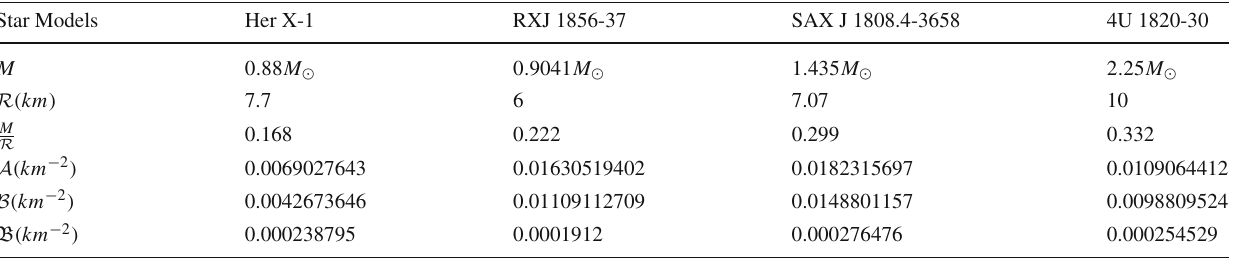
Table 1 Approximate values of unknown parameters A , B and B for compact star candidates Her X-1, RXJ 1856-37, SAX J 1808.4-3658 and 4U 1820-30 Star